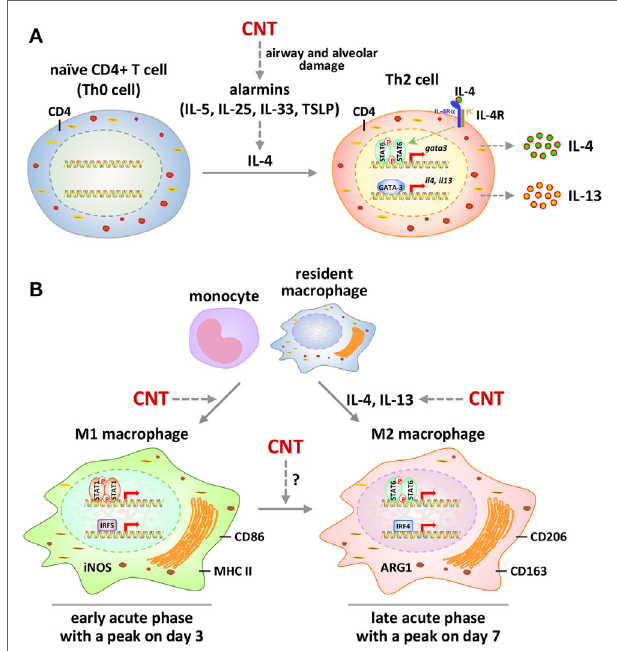
FiGURe 2 | Polarization and activation of Th2 cells and M1-M2 macrophages by carbon nanotubes (CNTs) in mouse lungs. (A) Polarization and signaling of Th2 cells. Exposure to CNTs stimulates the secretion of alarmins locally to induce the expression and production of type 2 cytokine IL-4 in the lungs. IL-4 promotes the differentiation of naïve CD4 + T cells to CD4 + Th2 cells. Activation of Th2 cells by IL-4 is mediated through the IL-4 receptor α /STAT6/GATA-binding protein 3 signaling cascade, leading to amplified production of IL-4 and IL-13. These type 2 cytokines function as the major inducing factors to drive the differentiation and activation of M2 macrophages and myofibroblasts to promote fibrosis. (B) Polarization and signaling of M1 and M2 macrophages. CNTs induce the polarization of M1 macrophages from infiltrated monocytes and resident macrophages in the lungs during the early-phase acute response. M1 polarization involves the activation of STAT1 and IRF5 signaling and the production of M1 markers, such as iNOS, CD86, and major histocompatibility complex II (MHC II). During the late phase of the acute response, M1 polarization declines to a lower level, whereas M2 polarization becomes a predominant phenotype. Activation of M2 macrophages is mediated through STAT6 and IRF4 signaling and is marked by the production of M2 markers, such as arginase 1 (ARG1), CD206, and CD163. In addition to the polarization of M2 cells from monocytes and resident macrophages, CNTs may stimulate an M1-to-M2 differentiation of macrophages in the